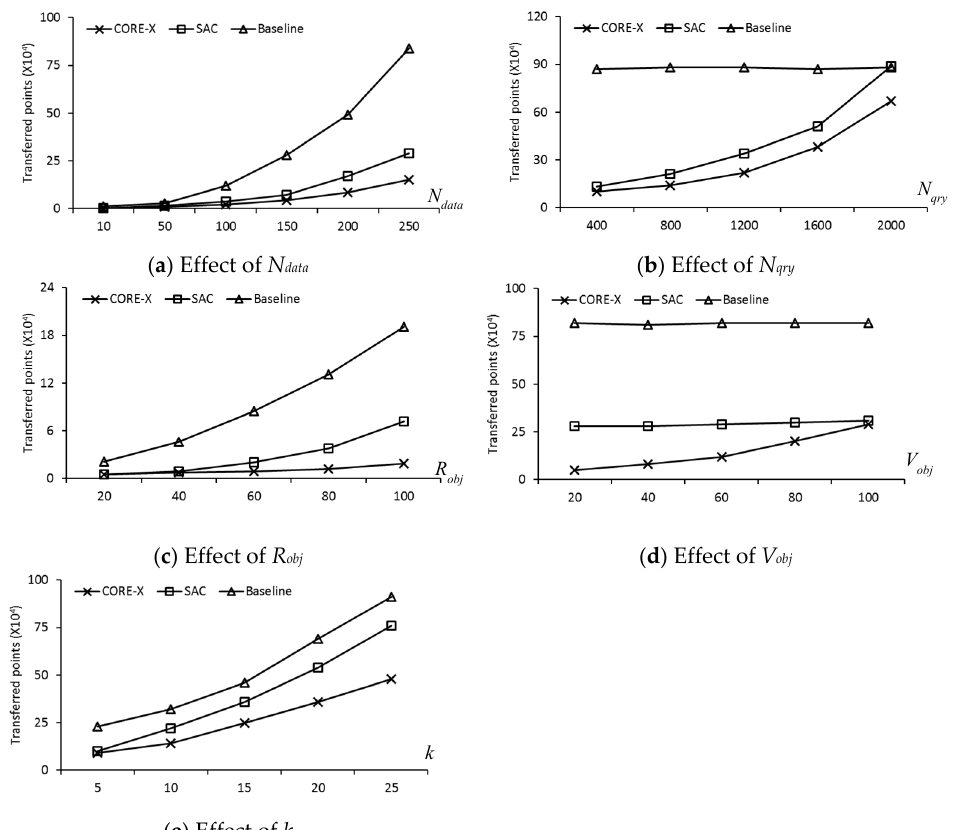
Figure 15. Comparison of the communication cost. ( a ) Effect of N data ; ( b ) Effect of N qry ; ( c ) Effect of R obj ; ( d ) Effect of V obj ; ( e ) Effect of k.